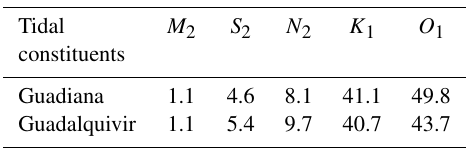
Table 3. Mean correction friction factor f for different tidal con- stituents along the Guadiana and Guadalquivir